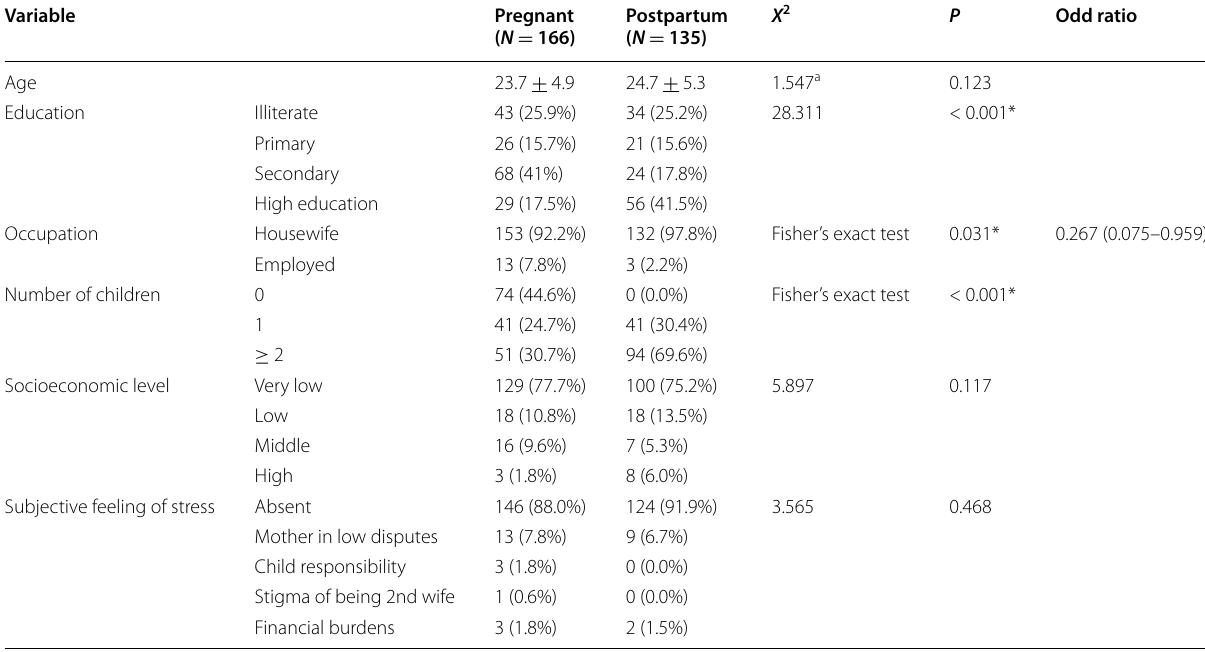
Table 1 Comparison between pregnant and postpartum women regarding the sociodemographic data and subjective feeling of stress scores